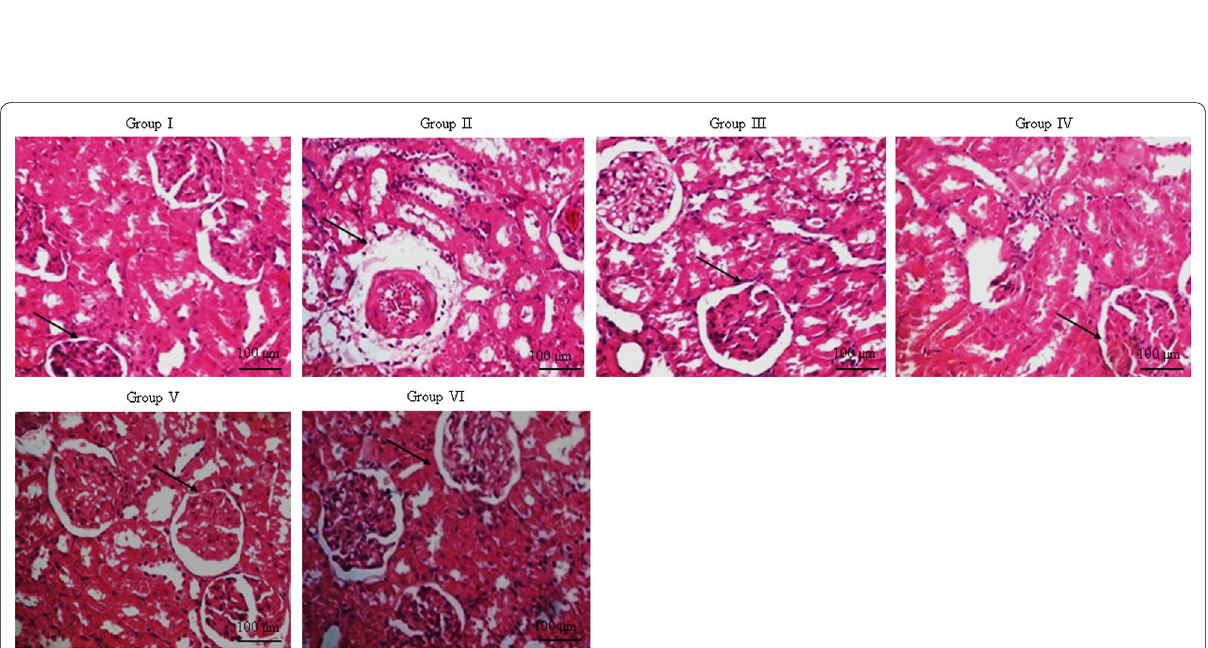
Fig. 6 Histopathological images showing the protective effect of erythropoietin and sesame oil in rats with ischemic kidney injury after kidney transplantation. The erythropoietin and sesame oil combination treatment markedly reduced necrosis. Magnification: